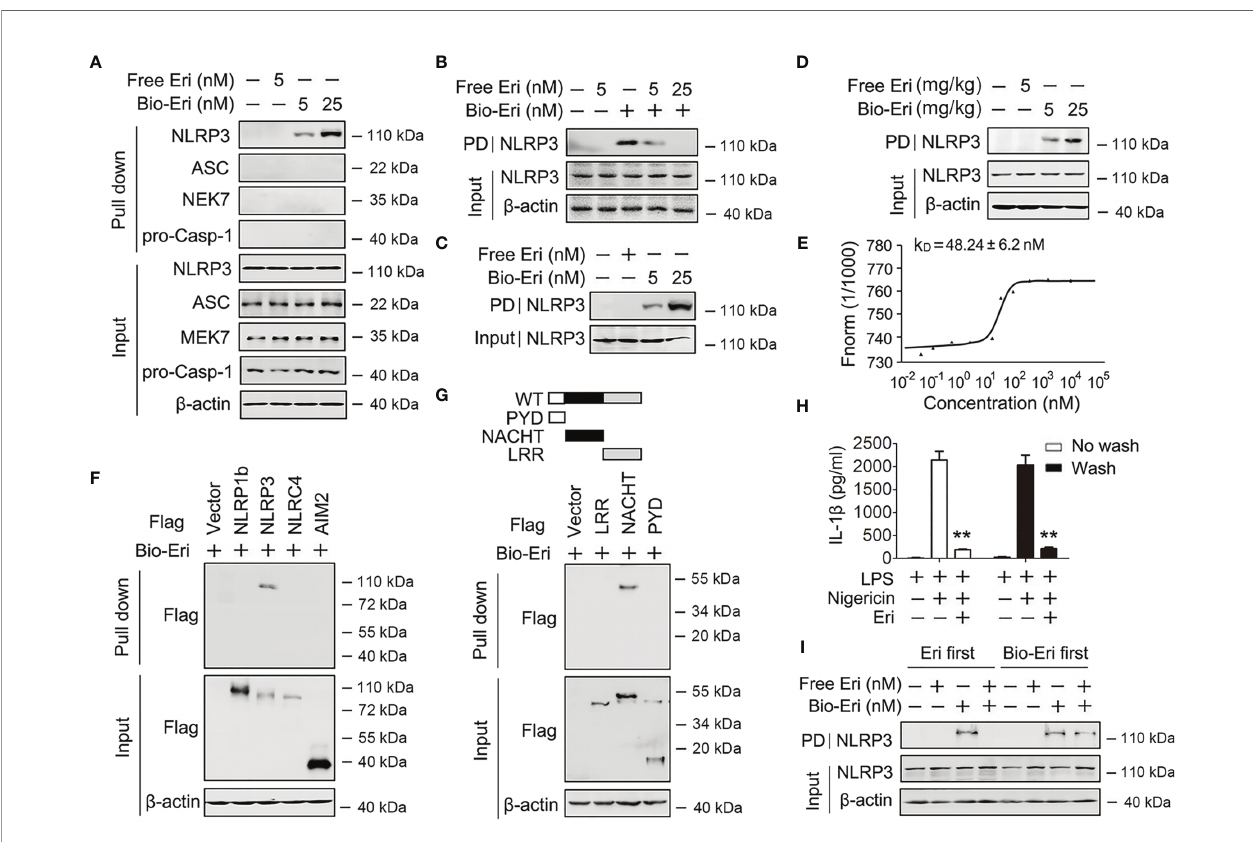
FIGURE 4 | Eri associates with NLRP3. (A) Immunoblot analysis of binding complexes isolated from BMDMs extracts incubated with biotin-labeled Eri (Bio-Eri) or free Eri. (B) BMDMs extracts were incubated with Bio-Eri and different concentrations of free Ori. The total proteins (input) and pulled down proteins (PD) were immunoblotted as indicated. (C) Puri fi ed human GST-NLRP3 protein was incubated with indicated doses of Bio-Eri. Total proteins (input) and pulled down proteins (PD) were immunoblotted as indicated. (D) C57BL/6 mice were intraperitoneally injected with the indicated concentrations of Eri or Bio-Eri for 12 h. Then, mice were intraperitoneally injected with MSU (1 mg/mouse) for 6 h The total proteins (input) and pulled down proteins (PD) in peritoneal fl uids were immunoblotted as indicated. (E) MST assay for the af fi nity between Ori and puri fi ed GST-NLRP3 protein. (F) HEK293T cells were transfected with indicated plasmids for 36 h. Immunoblot analysis of binding complexes isolated from cells extracts incubated with Bio-Eri. (G) Schematic diagram of the full-length and truncated constructs of NLRP3 (upper panel). HEK293T cells were transfected with indicated plasmids for 36 h. Immunoblot analysis of binding complexes isolated from BMDMs hextracts incubated with Bio-Eri (lower panel). (H) BMDMs were treated with LPS (1 µg/ml for 6 h) or Eri (5 nM for 15 min), and washed or no washed for three times. Then, cells treated with Nigericin (2 m M) for 2 h. IL-1 b protein levels in supernatant were determined by ELISA. (I) BMDMs extracts were incubated with free Eri for 4 h before or after incubated with bio-Ori (1 m M) for 4 h. Total proteins (input) and pulled down proteins (PD) were immunoblotted as indicated. All experiments were repeated at least three times. Bar graphs present means ± SD (**P <